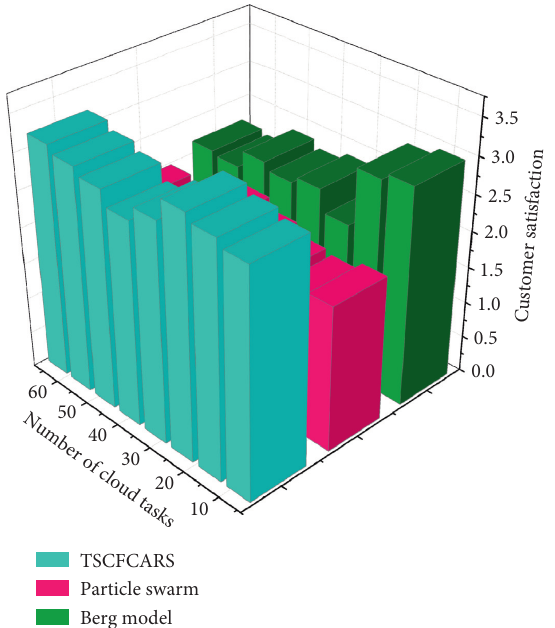
Figure 9: Comparison of user satisfaction with fewer cloud service